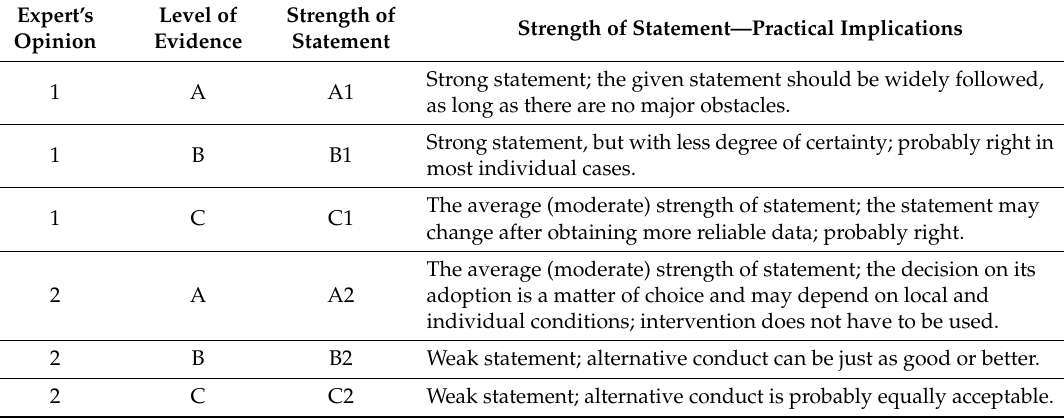
Table 3. Strength of